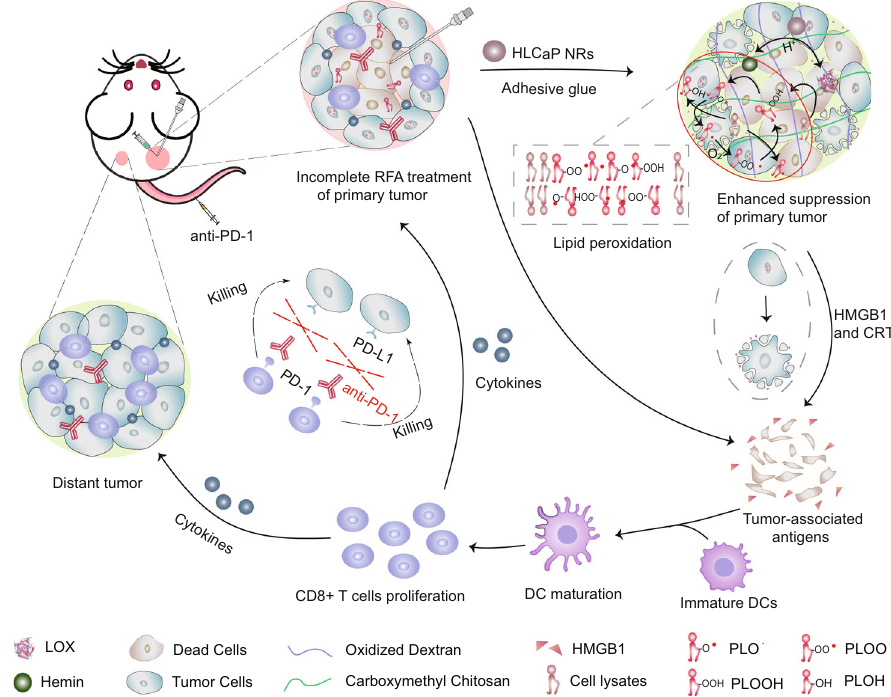
Fig. 1 A scheme illustrating the mechanism of tumor debris fueled tumor-killing HLCaP NRs in enhancing RFA treatment and boosting antitumor immunity. Upon being fi xed inside the residual tumors post incomplete RFA with adhesive glue, such HLCaP NRs in responsive to the acidic tumor microenvironment will gradually release LOX and hemin, and synergistically cause continuous lipid peroxidation from these PUFA containing phospholipids inside the tumor debris to trigger ferroptosis of residual tumor cells. Meanwhile, the released HMGB1 molecules from these ferroptotic cancer cells will recruit immature DCs to the residual tumor site and prime speci fi c antitumor immune response featured in increased in fi ltration of effector T cells and secretion of effector cytokines, to further inhibit the growth of both residual tumors and metastatic (distant) tumors, especially in the combinational use of anti-PD-1